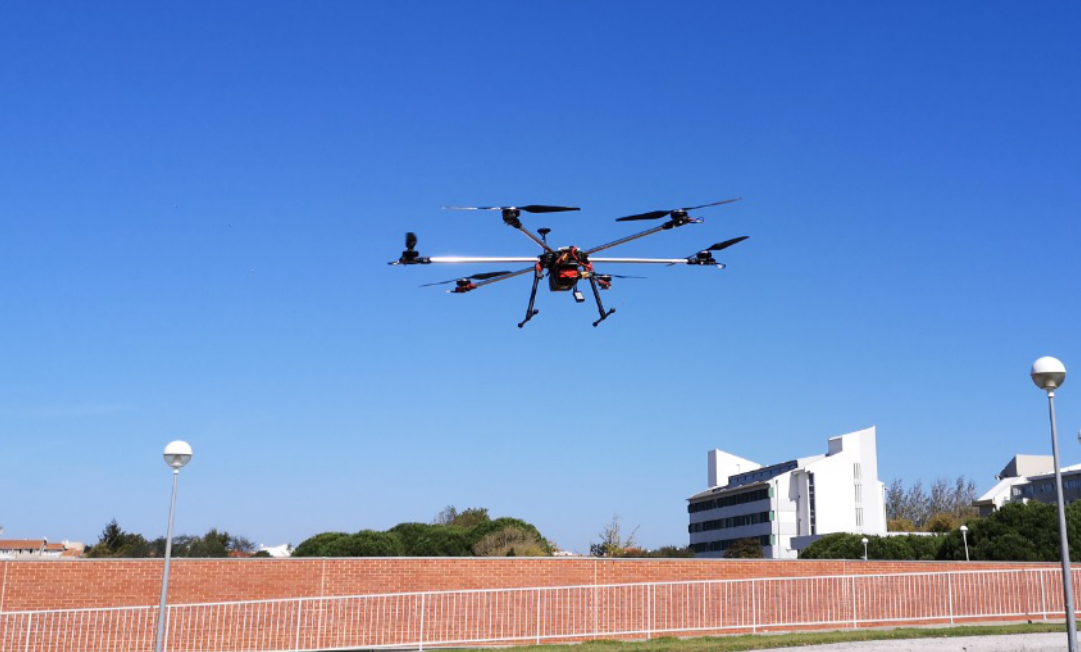
Figure 13. Preliminary tests of the UAV flying over a